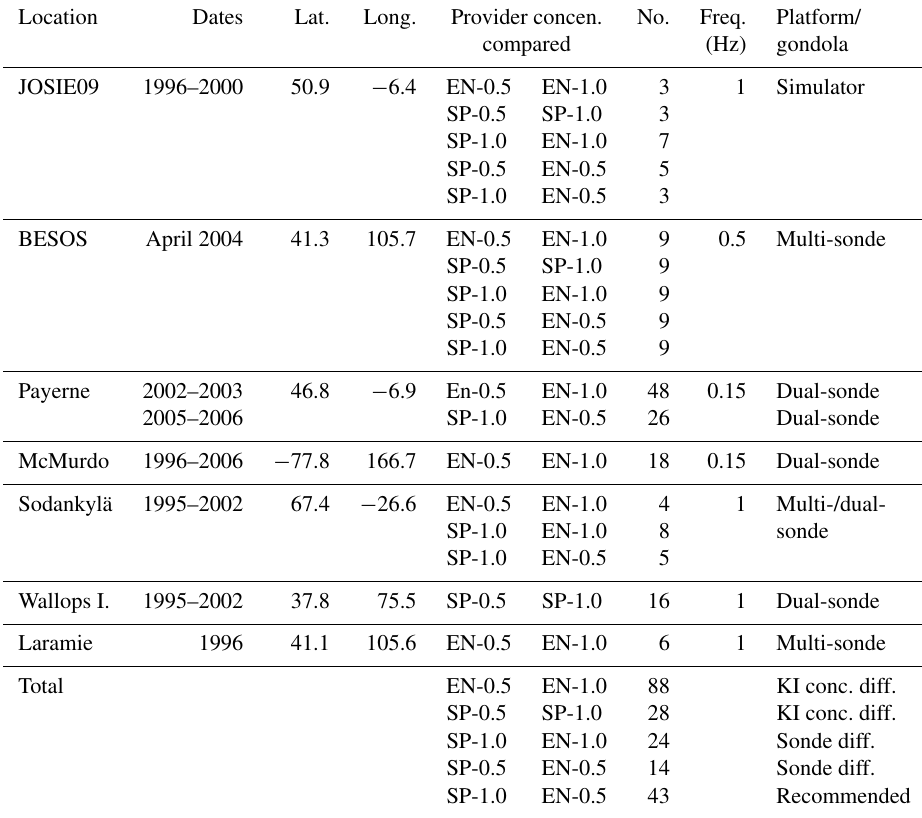
Table 1. Data sets used in the analysis giving experiment or location, years of the comparisons, location latitude and longitude, ozonesonde and solution strengths compared, number of comparisons, sampling frequency of the data (Hz), and the platform. The multi-sonde platforms contained from 4 to 12 ozonesondes. Dates Lat.